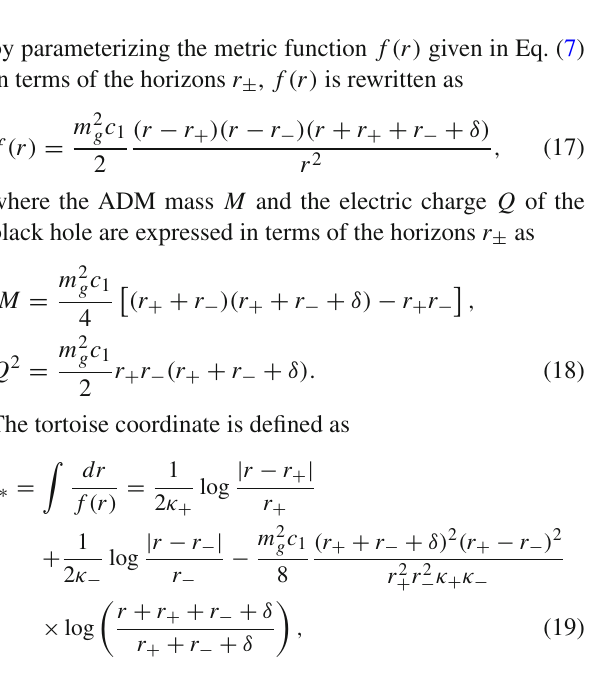
Fig. 3 The black hole mass function M ( r h ) versus the event horizon radius r h , which is inferred from the equation f ( r h ) = 0, at Q = 1, m g = 1, and c 1 =